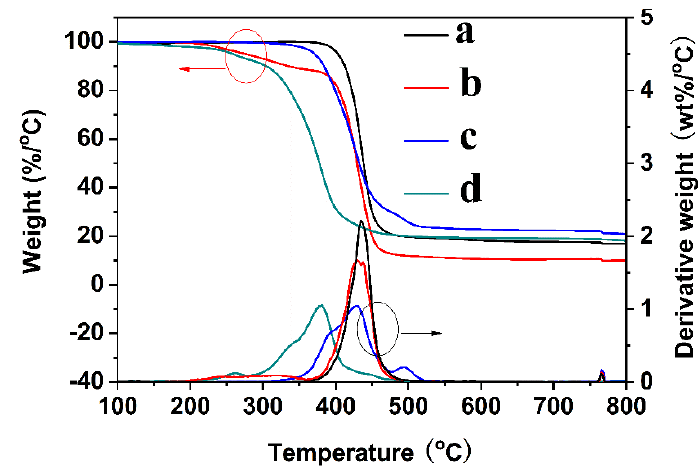
Figure 5. TG and derivative TG (DTG) curves of pristine PET fabric ( a ), PET ‐ g ‐ PMAPS ( b ), ZnO ‐